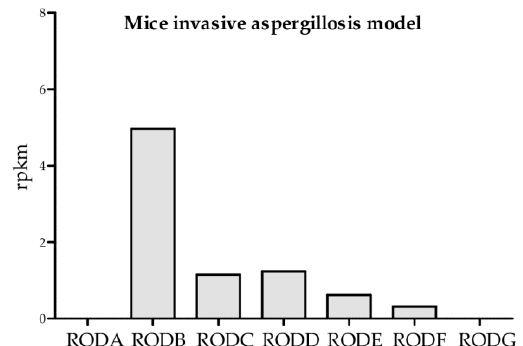
Figure 2. Expression of the different hydrophobin genes under different conditions.